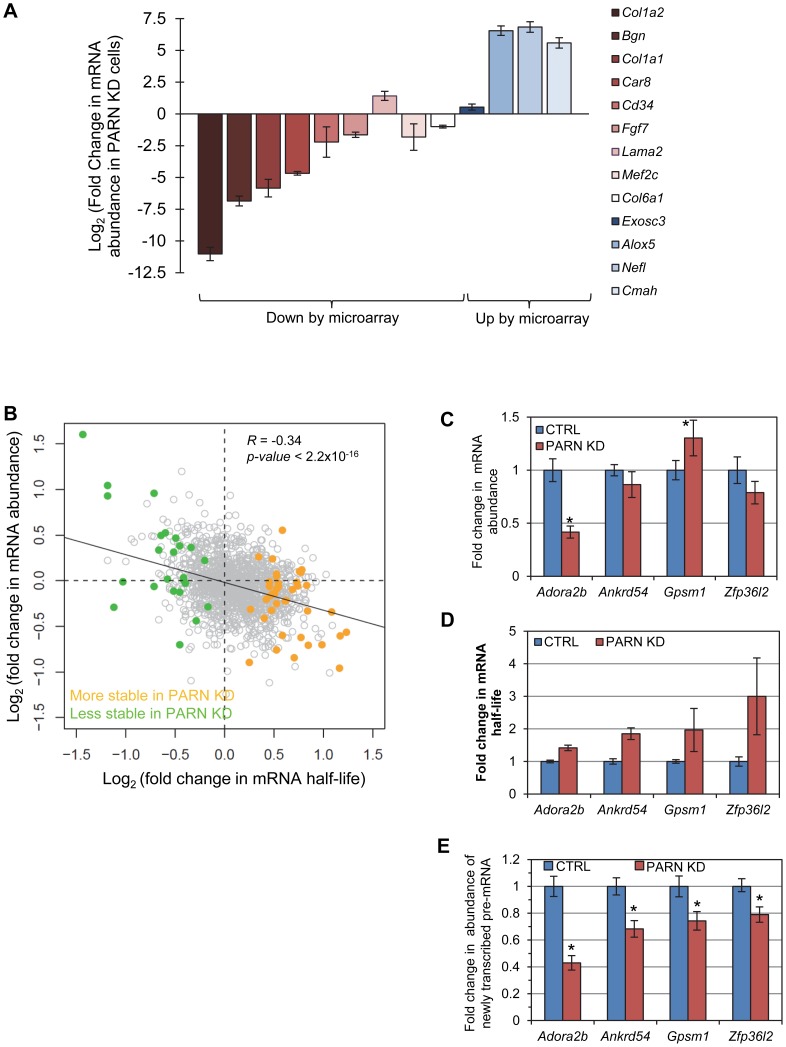
mRNA stabilization is not correlated with increases in mRNA abundance.(A) mRNAs that were predicted by the microarray to have significantly altered abundance were evaluated by qRT-PCR. Fold change in abundance in the PARN KD cell line as compared to the CTRL cells is shown. Error bars represent the pooled standard deviation from three independent experiments. Asterisks indicate statistically significant differences (p<0.05). (B) Scatter plot of fold change in abundance versus fold change in mRNA half-life for those mRNAs that showed significant changes in stability in PARN KD cells. The transcripts indicated in orange had increased stability following PARN KD, those in green were destabilized by PARN KD. Transcripts shown in grey had no significant change in half life. (C) The abundance of four transcripts that were stabilized following PARN depletion was evaluated in CTRL and PARN KD cell lines by qRT-PCR. The error bars represent the pooled standard deviation derived from four experiments. Statistically significant differences (p<0.05) are indicated by an asterisk. (D) The fold change in mRNA half-life for each mRNA is shown for comparison. This bar chart is derived from the same data as shown in Figure 2. (E) The abundance of newly transcribed pre-mRNAs was assessed by qRT-PCR and normalized to abundance of 7SL RNA. Statistically significant differences from the control (p<0.02) are indicated by asterisks.